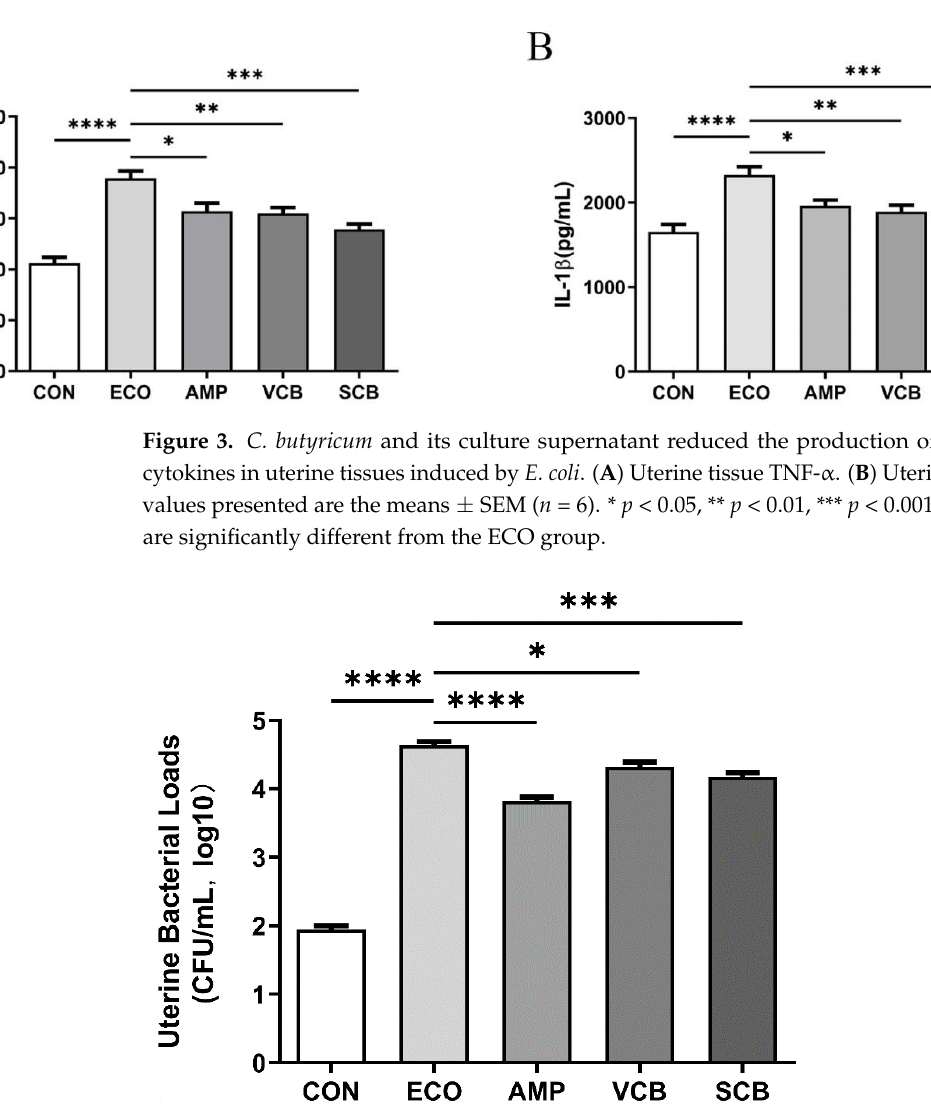
Figure 4. C. butyricum and its culture supernatant reduced the uterine bacterial loads. The values presented are the means ± SEM ( n = 6). * p < 0.05, *** p < 0.001, and **** p < 0.0001 are significantly different from ECO group.